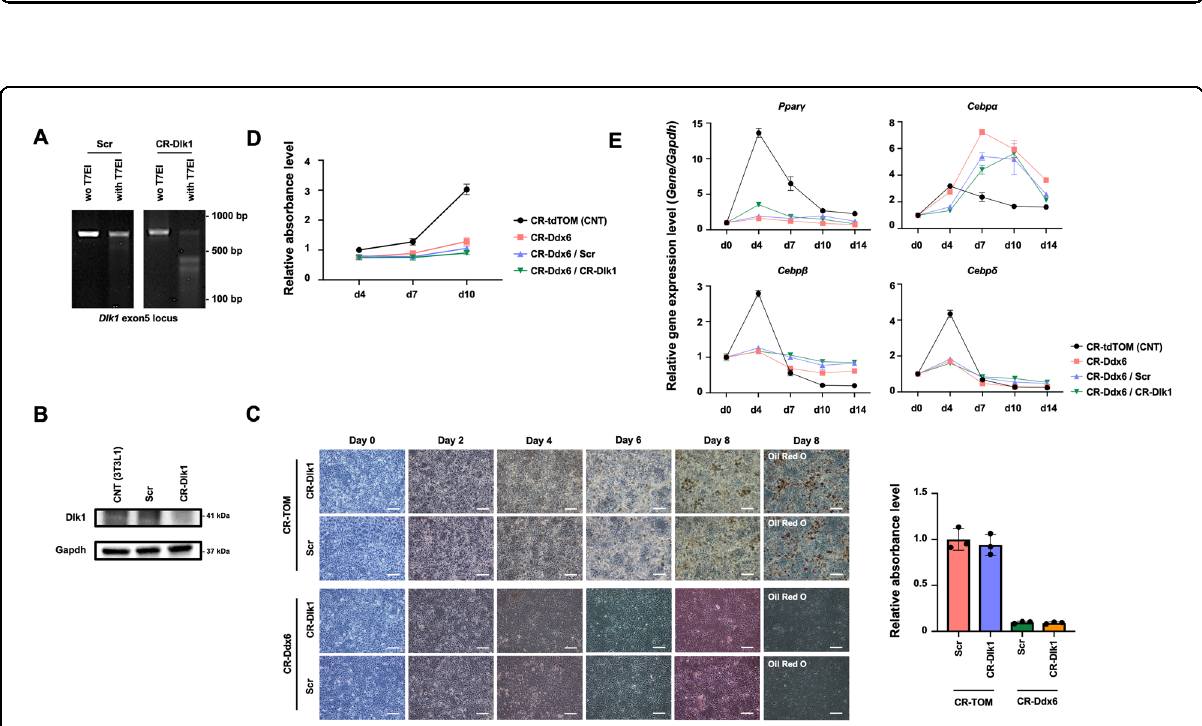
Fig. 5 Expression pro fi ling of mRNA changes during the early phase of adipogenic differentiation. A Volcano plots at the early phase of adipogenesis in TOM-transfected and 3T3L1 Ddx6-KD preadipocytes. B Heatmap of 12 selected genes whose expression was reduced twofold in 3T3L1 TOM cells but not in 3T3L1 Ddx6-KD cells. C Venn diagram showing the number of mRNAs relevant to each segment. D Protein – protein interaction network of 12 intersecting genes predicted by STRING analysis.